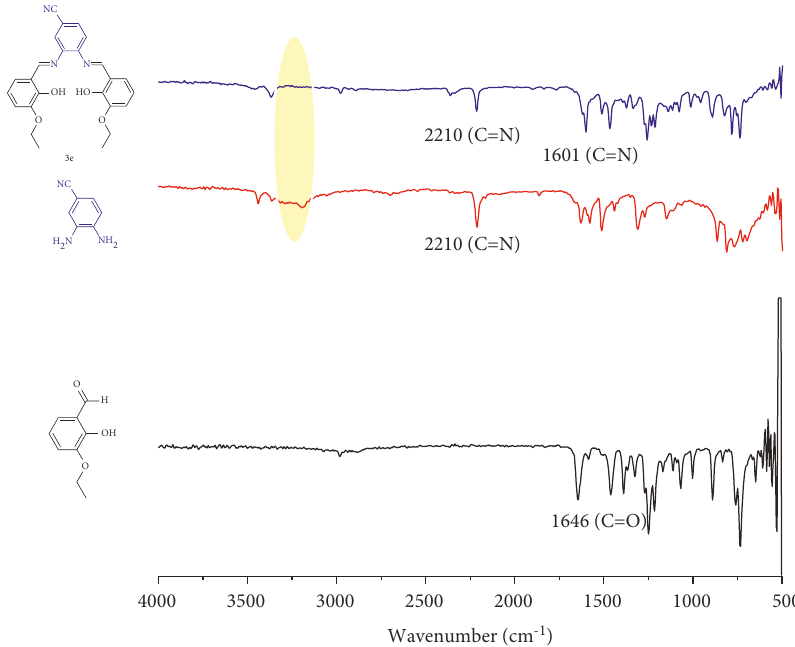
Figure 2: FT-IR spectra of aldehyde, diamine, and Salophen ligand.